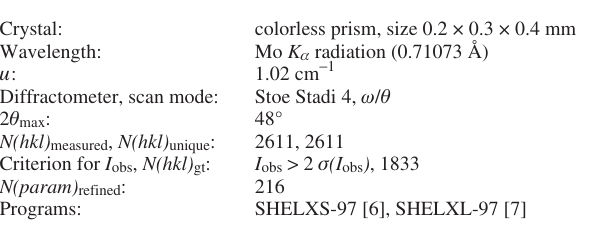
Table 1. Data collection and handling.